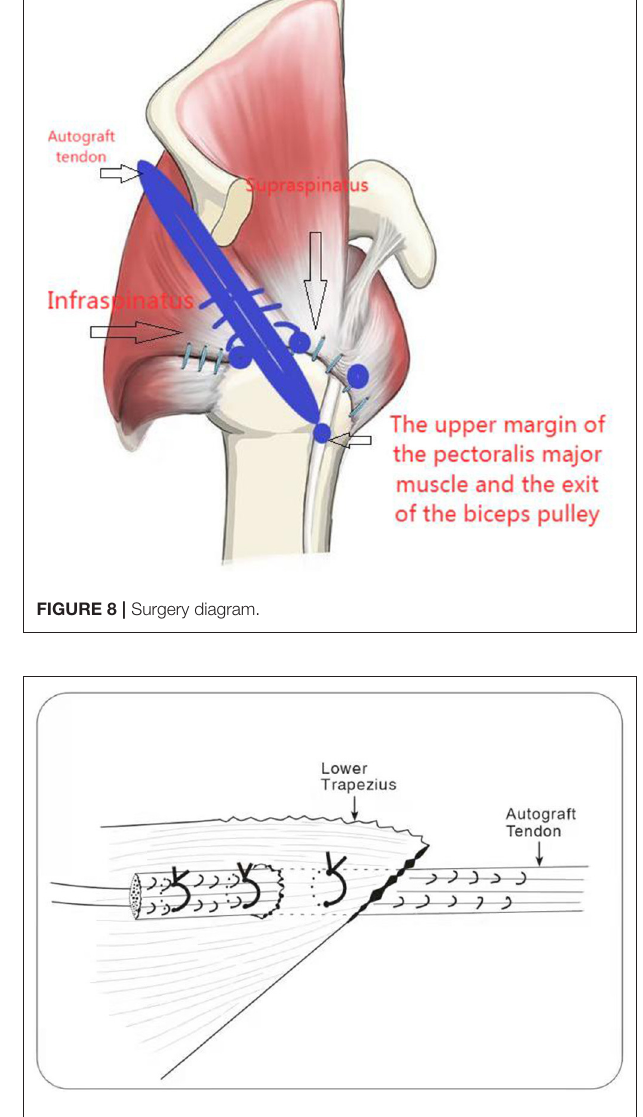
FIGURE 9 | Schematic representation of autograft fixation to the lower